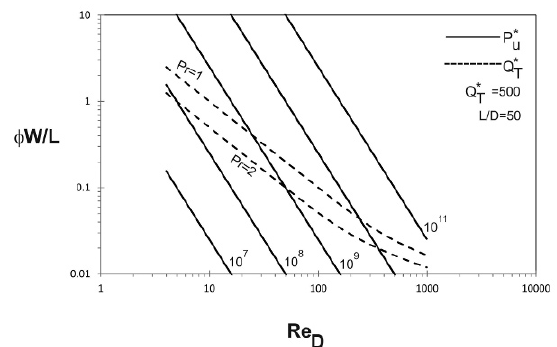
Figure 17. Influence of the Prandtl number on the variation of group with the Reynolds number (laminar regime and prescribed wall temperature boundary)